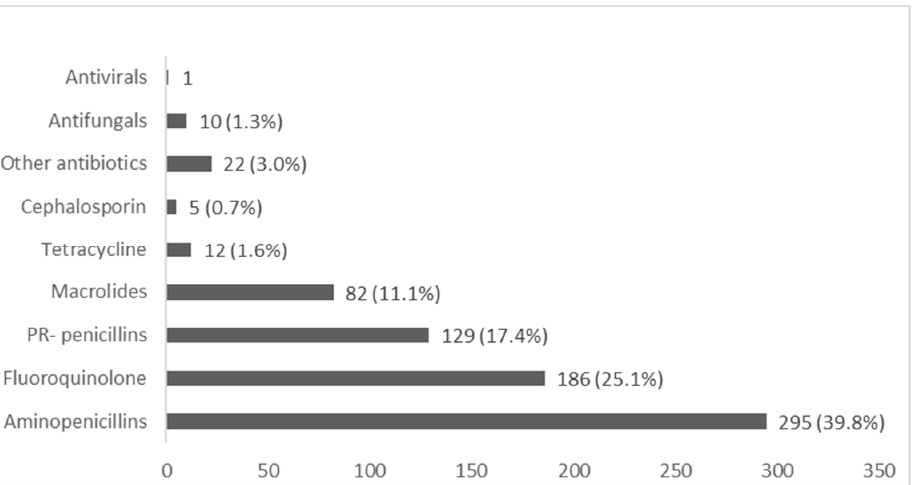
Figure 2. Commonly dispensed antimicrobials in community pharmacy. Aminopenicillin; Amoxi-